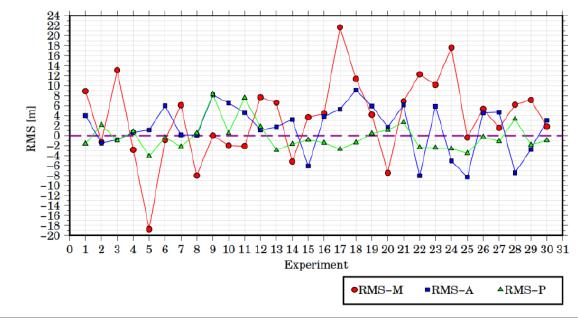
Figure 11. RMS of